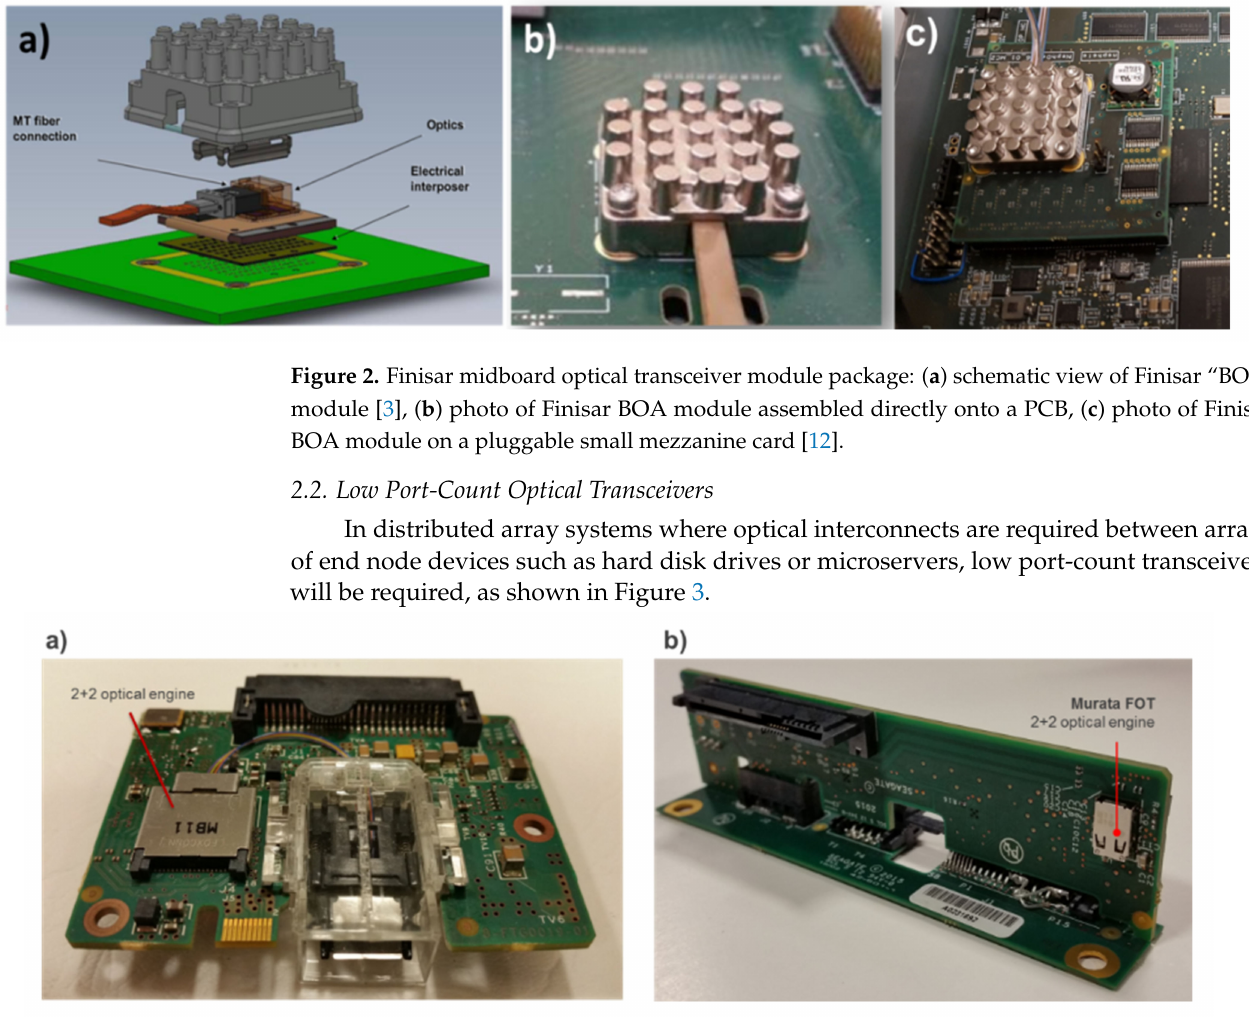
Figure 3. Low port-count transceivers on end node interface cards: ( a ) Avago McLight 2 + 2 transceiver on ThunderValley2 disk drive interface card, ( b ) Murata FOT 2 + 2 transceiver on Pegasus end node interface